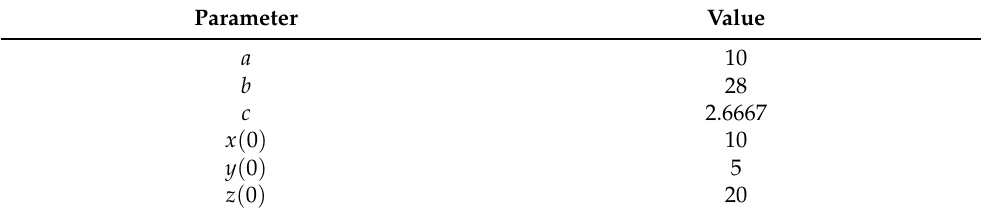
Table 1. Parameter values of the Lorenz attractor as in